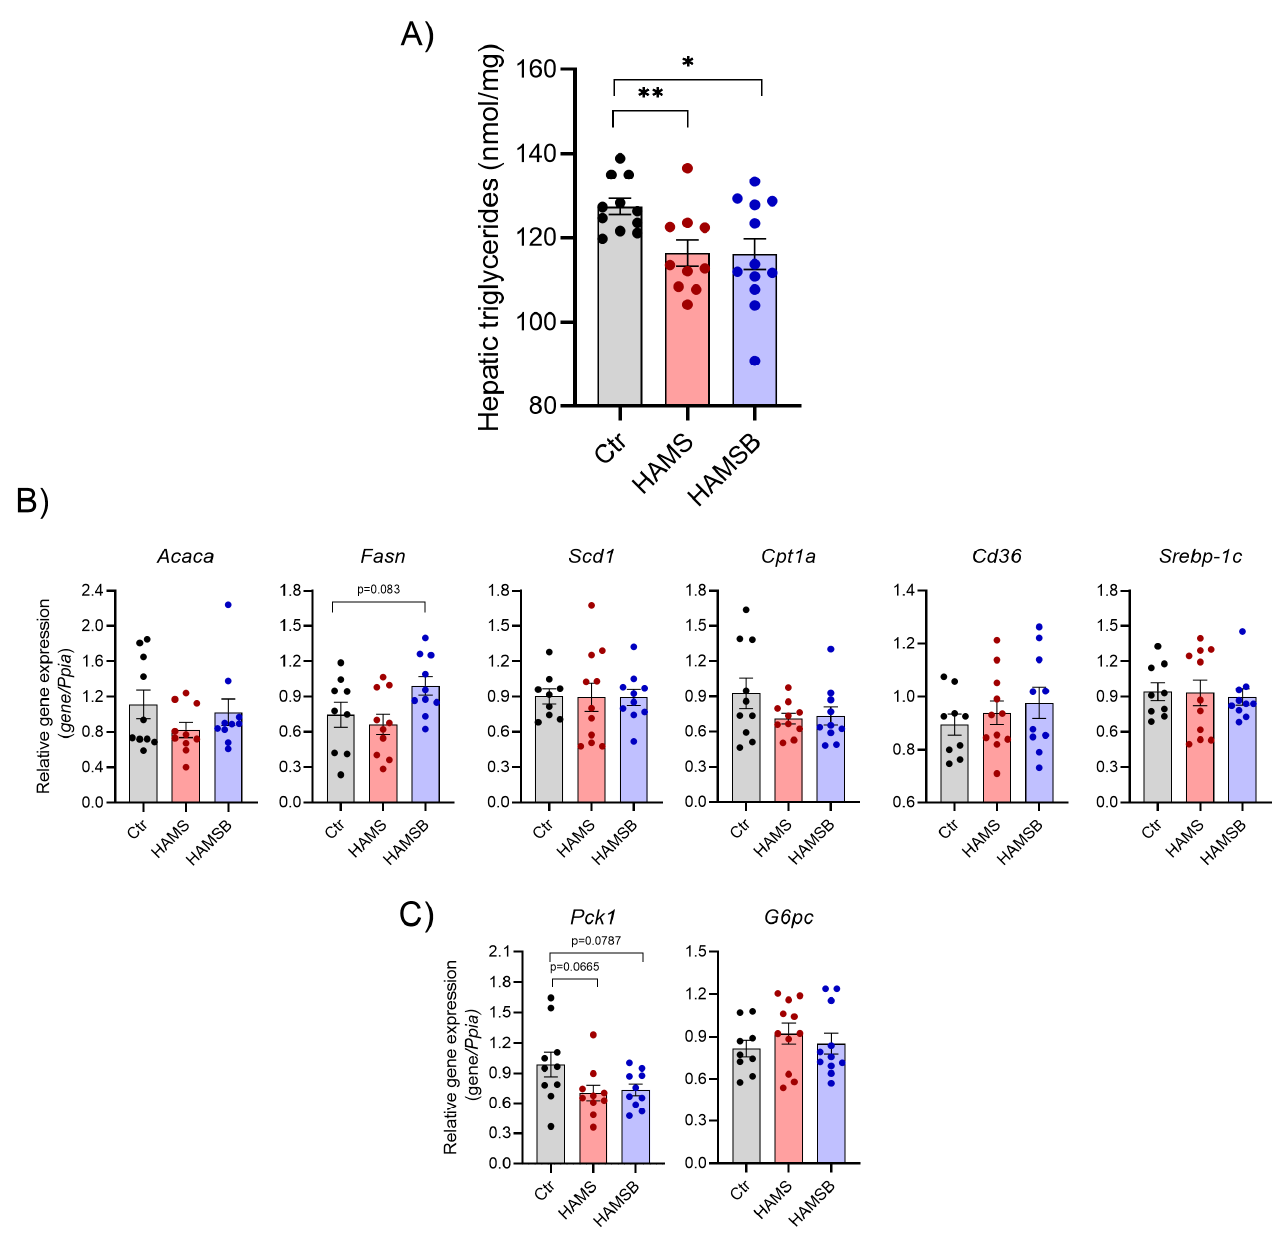
Figure 6. Hepatic lipid and glucose metabolism. ( A ) Triglycerides were measured in livers of db/db mice fed a control diet or a diet supplemented with HAMS or HAMSB for 5 weeks. Total RNA was extracted from the livers and gene expression of the genes involved in lipid metabolism ( B ) or gluconeogenesis ( C ) were measured by RT-qPCR. Data are normalized to the reference gene Ppia . Bars show the mean ± SEM. * p < 0.05, ** p < 0.01. Acaca , acetyl-CoA carboxylase; Fasn , fatty acid synthase ; Scd1 , stearoyl-CoA desaturase 1 ; Cpt1a , carnitine palmitoyltransferase 1A ; Srebp-1c , sterol regulatory element-binding protein-1c ; Cd36 , cluster of differentiation 36 ; Pck1 , phosphoenolpyruvate carboxykinase 1 ; G6pc , glucose - 6 - phosphatase. Each circle represents pools of islets from mice.